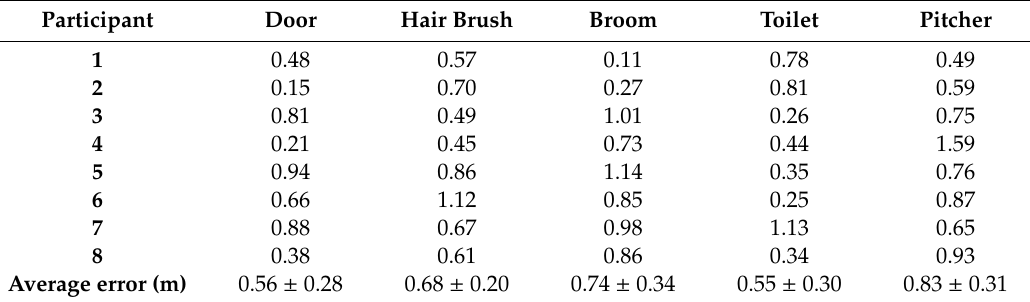
Table 4. Localization error of active